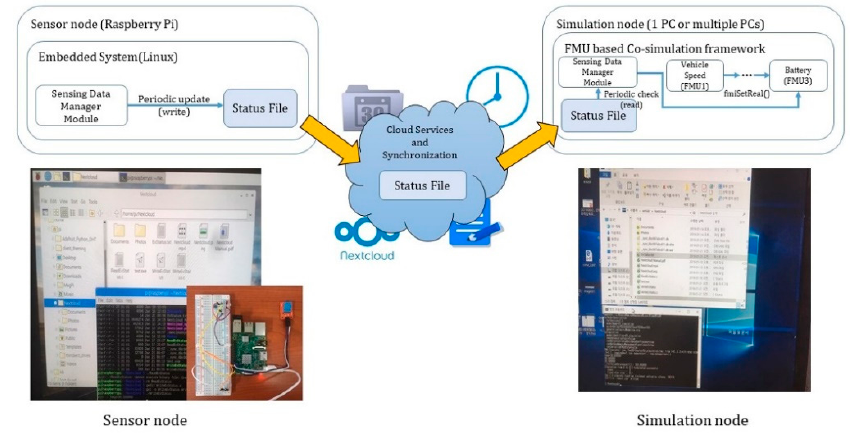
Figure 13. Simulation model including sensor information.